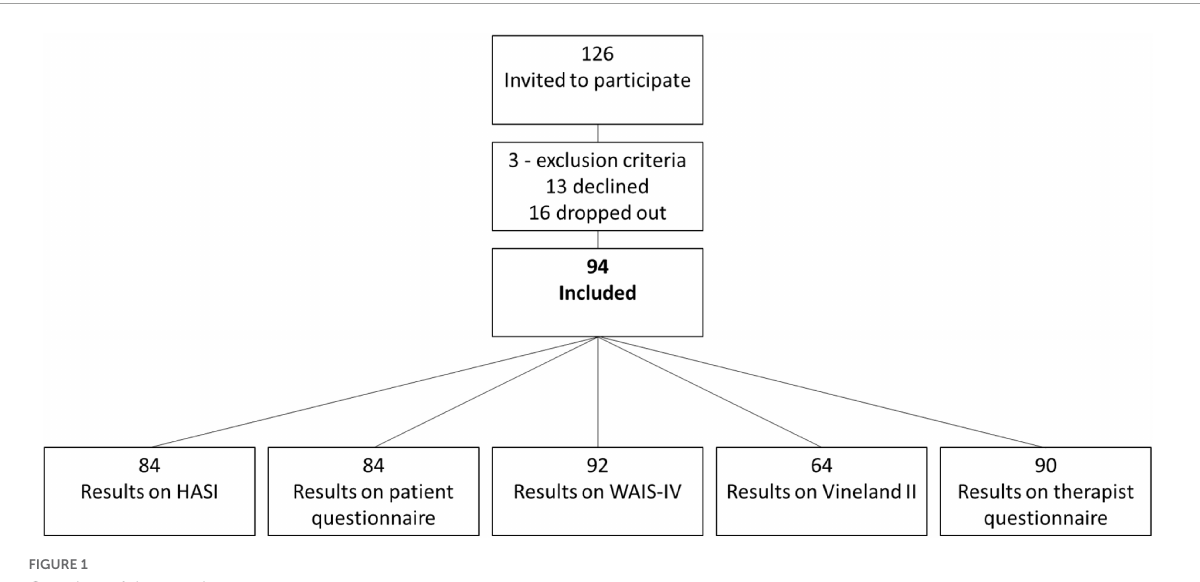
FIGURE1 Overview of the recruitment